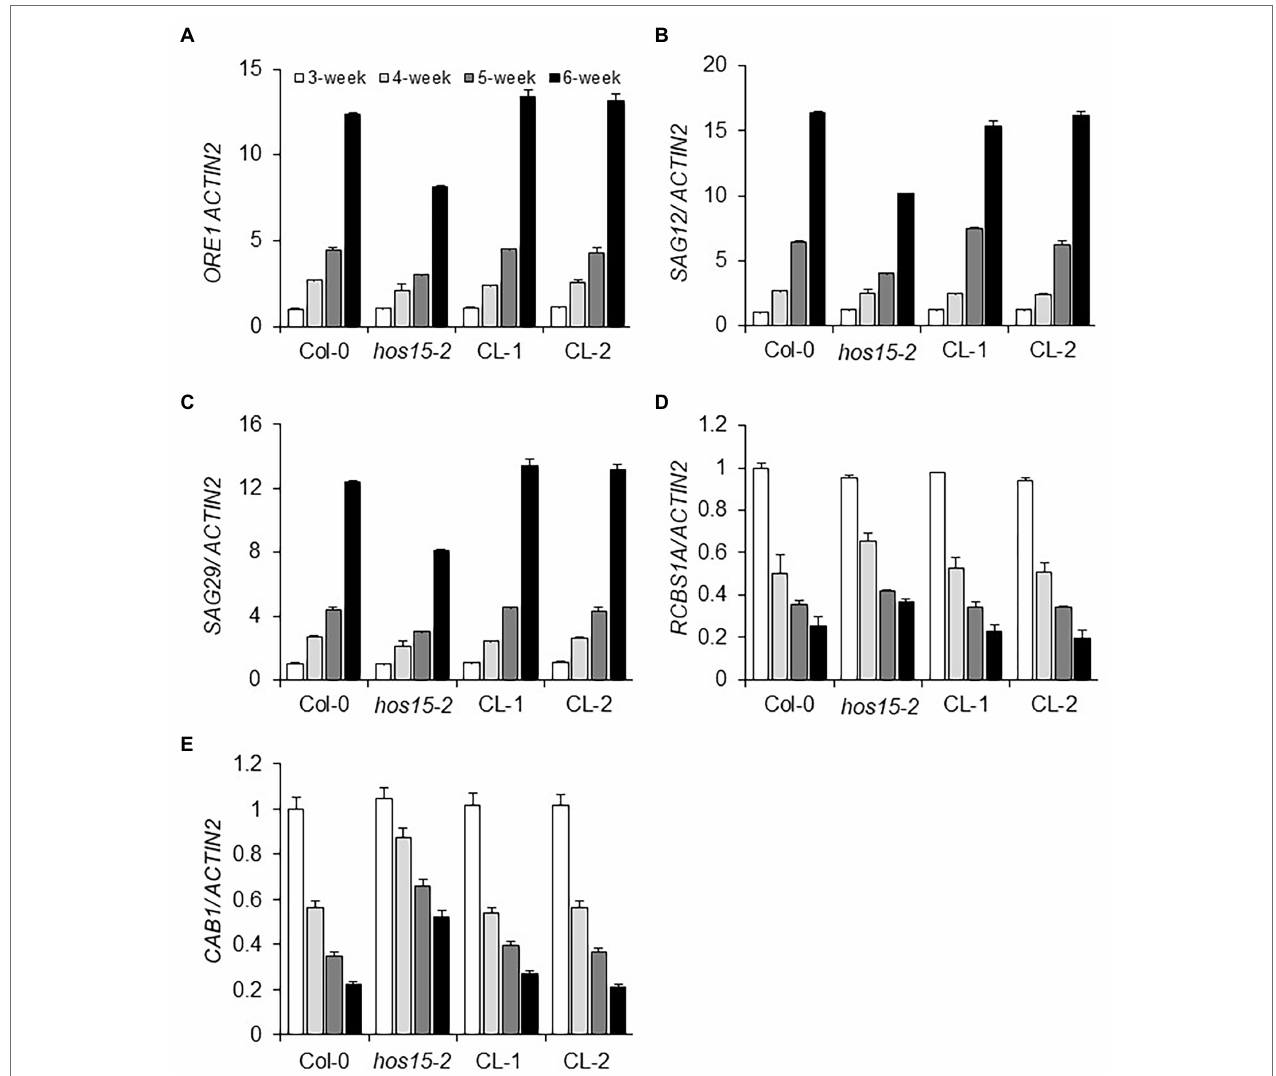
FIGURE 2 | HOS15 differentially regulates senescence- and photosynthesis-related genes in an age-dependent manner. Comparative transcript level analysis of senescence- and photosynthesis-related genes in Col-0 (WT), hos15-2 , CL-1, and CL-2 plants in an age-dependent manner. (A–E) The 3rd and 4th rosette leaves of Col-0, hos15-2 , CL-1, and CL-2 were sampled at the 3rd, 4th, 5th, and 6th weeks of germination, total RNA was extracted, and cDNA was synthesized. The transcript level of three senescence-related marker genes, ORE1, SAG12 , and SAG29 , and two photosynthesis-related genes, CAB1 and RBCS1A , were quantified through qRT-PCR and normalized to 3rd week Col-0. ACTIN2 was used as the normalization control. Error Bars indicate SD of three independent biological repeats of each